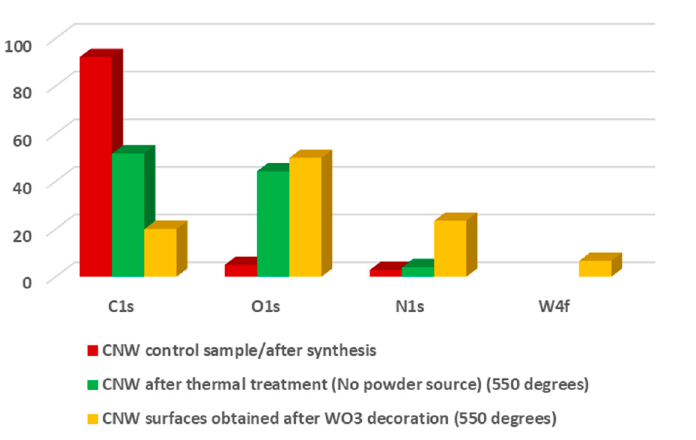
Figure 15. Bar diagram of the elemental composition corresponding with the four major zones (C1s, O1s, N1s, W4f) for all three investigated samples (CNW control sample, CNW after thermal treatments, respectively nanostructures obtained after WO 3 decoration) in plasma on condition.